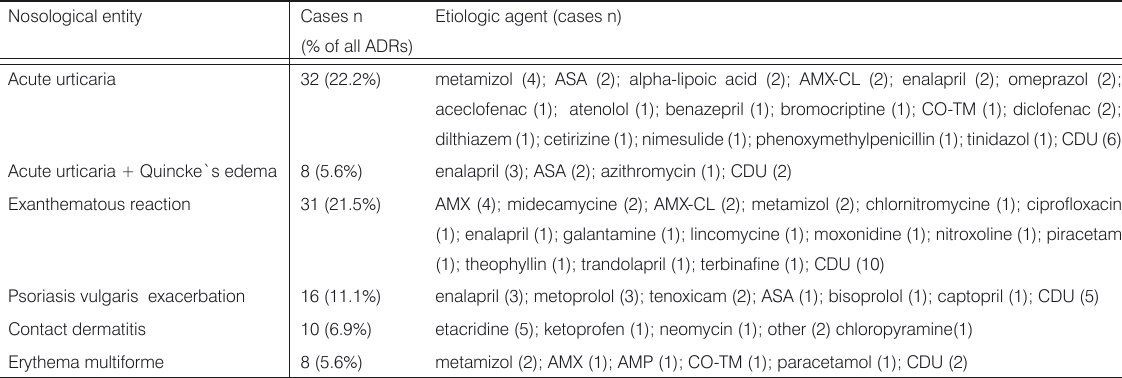
Table 2. Most common ADRs leading to hospitaization - clinical manifestation and etiologic